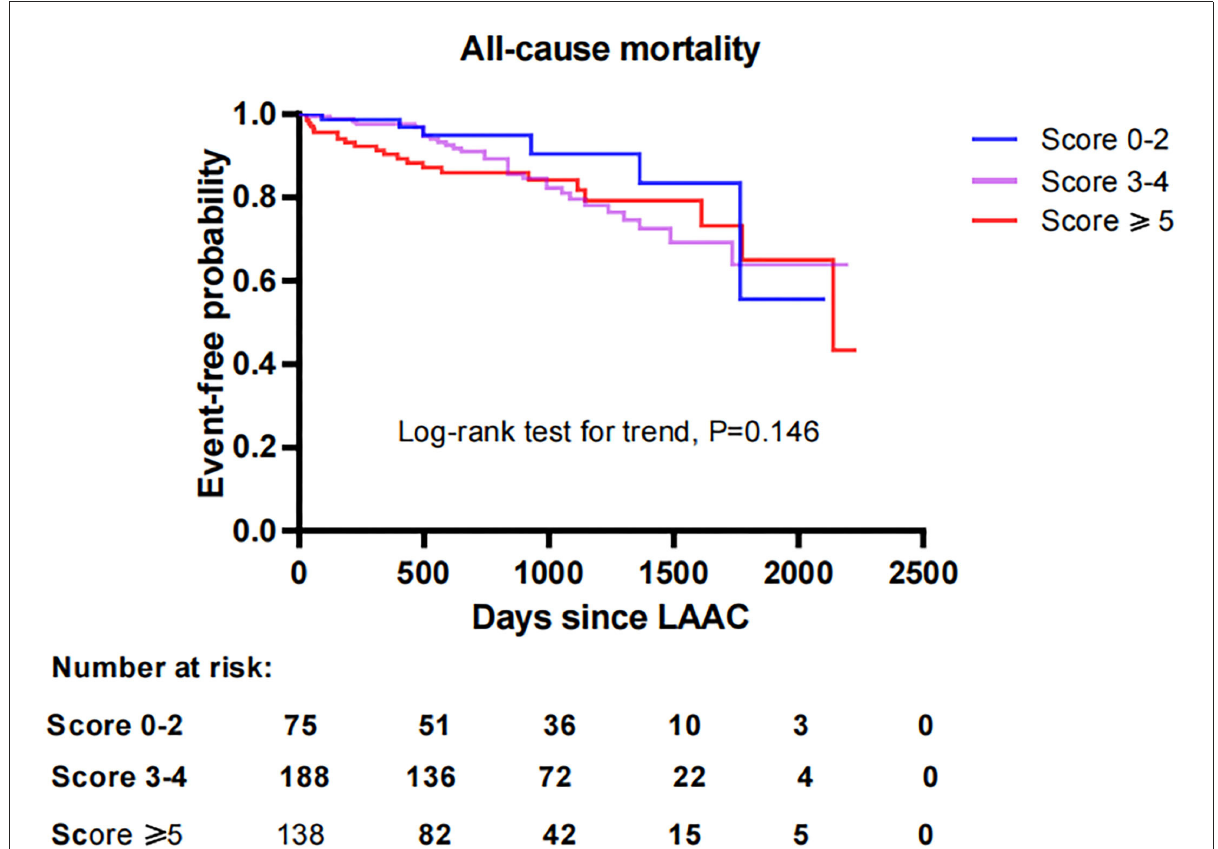
FIGURE1 Comparison of the cumulative ratio of freedom from all-cause mortality in different subgroups. LAAC, left atrial appendage